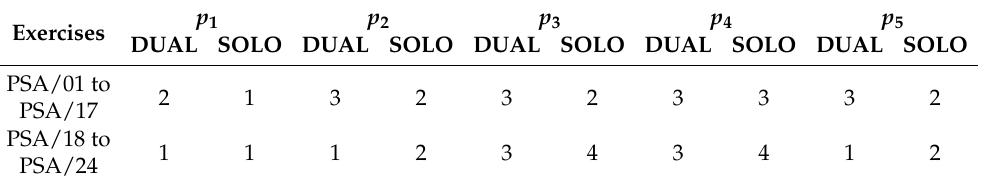
Table 4. Input data from flight training